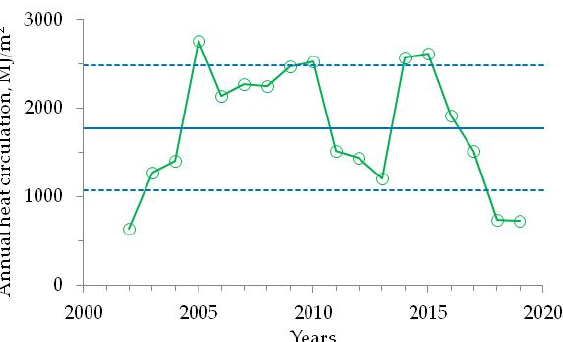
Figure 3. Interannual changes in the heat circulation in the entire water column (green curve with circles). The blue line is the average value of the annual heat circulation from 2002 to 2019, and the blue dotted lines are SD limits.